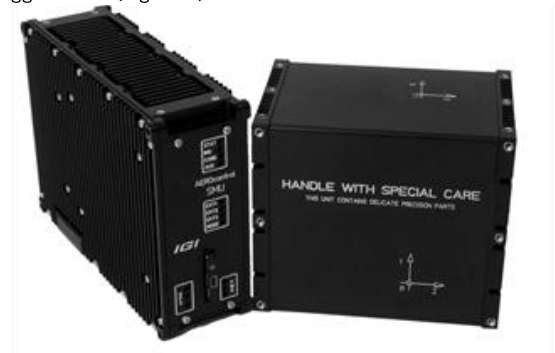
Figure 6: TERRAcontrol system with IMU-IIe